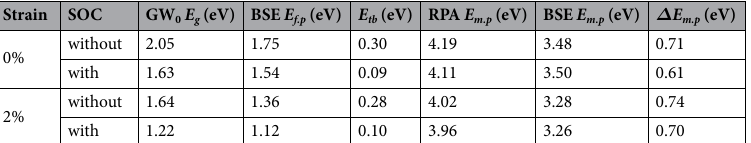
Table 2. Intrinsic properties of monolayer stanane, including GW 0 band gap at Γ ( E g ), first absorption peak ( E f.p ), binding energy of tight binding exciton ( E tb ), maximum intensity of the absorption peak ( E m.p ) and the redshift of E m.p ( Δ E m.p ) under 0% and 2% strain with and without